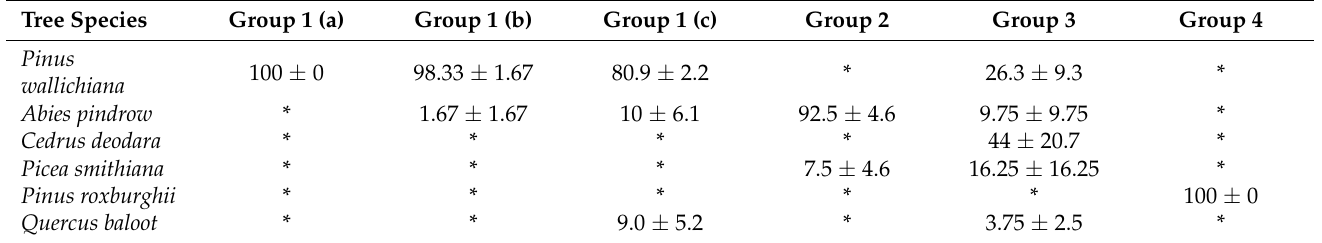
Table 1. Four groups derived from Ward’s cluster analysis of 40 stands and their average tree species composition (average importance value for each